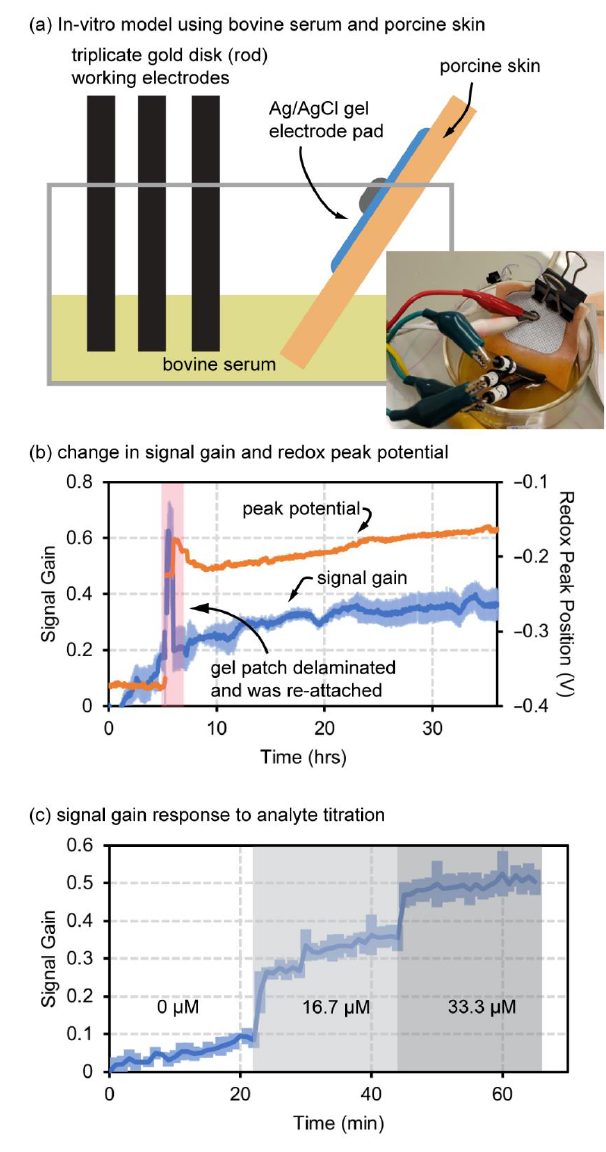
Figure 5. Simulated in vivo environment results. ( a , b ) Signal gain degradation and peak potential drift of simulated in vivo model using the peak-tracking software with porcine skin in bovine serum as a model for dermal interstitial fluid biosensing. ( c ) Signal response of peak-tracking software during vancomycin titration. Lastly, a simple, in vitro titration was performed with the Cassio board potentiostat and software, using a Ag/AgCl reference electrode, 4 functionalized EAB sensors, and a platinum counter in 1x PBS. Titrating vancomycin presented clear regions of signal gain for each concentration demonstrating sensitivity and utility of these sensors while the scanning window is continually updated and with partial windows (Figure 5c). This final test further demonstrates that the software still works appropriately even as the redox peak height changes with addition of target.